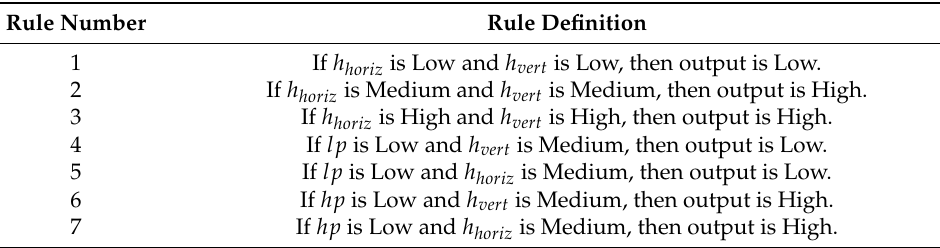
Table 3. The Rule Base for the Fuzzy System.